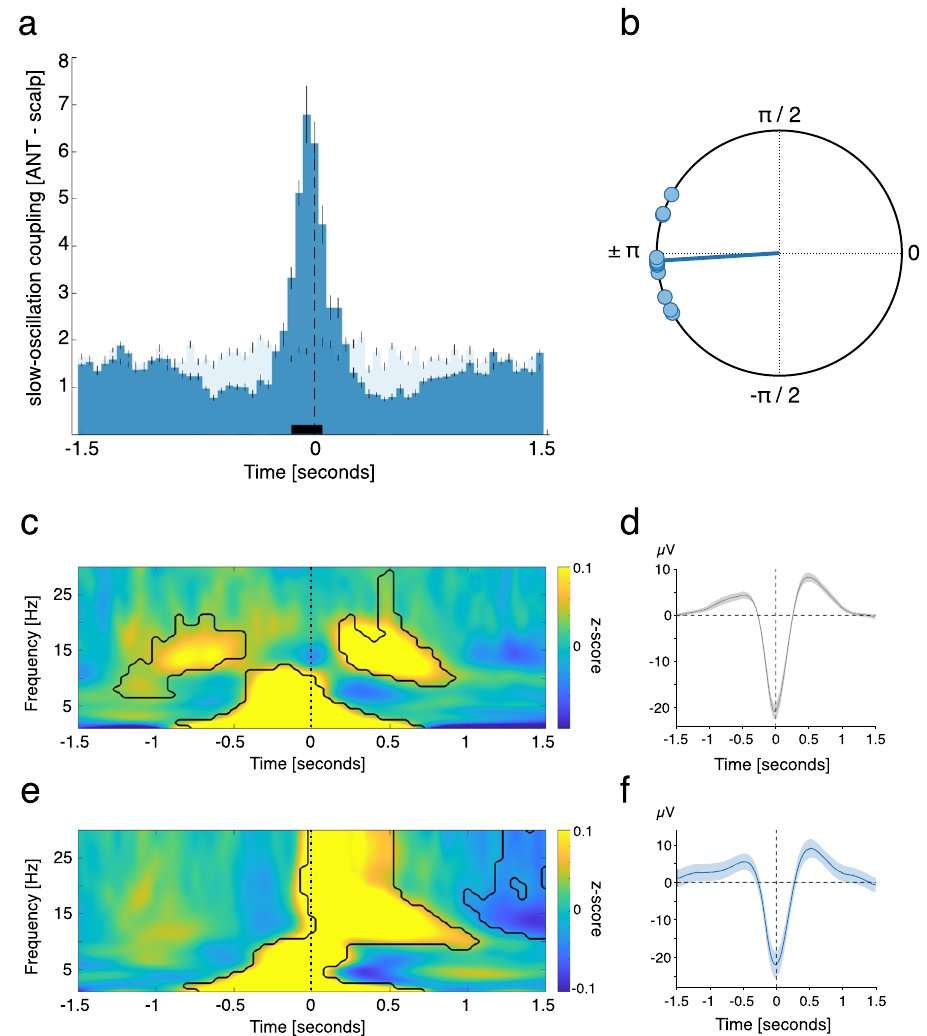
Fig. 2 | ANT SOs precede neocortical SOs. a Occurrence probabilities of ANT SO down-state peaks relative to neocortical SO down-state peaks (time=0; dashed line; bin size = 50ms), indicating that ANT SOs precede neocortical SOs. The solid black bar indicates signi fi cant differences, resulting from comparison with SO-free control events as derived from a dependent-samples t -test (two-sided, positive cluster from − 0.15 to 0.05s, p <0.005; time of peak: − 0.05s, cluster corrected across time). b Phase of ANT SOs at the time of neocortical SO down-states for paired SO – SO events, illustrating that ANT SO phases preceded their neocortical counterparts (phase of neocortical SO down-states corresponds to ± π ; mean coupling direction: − 176.39±4.94°; Rayleigh test, one-sided: p <0.0001; z =10.95).